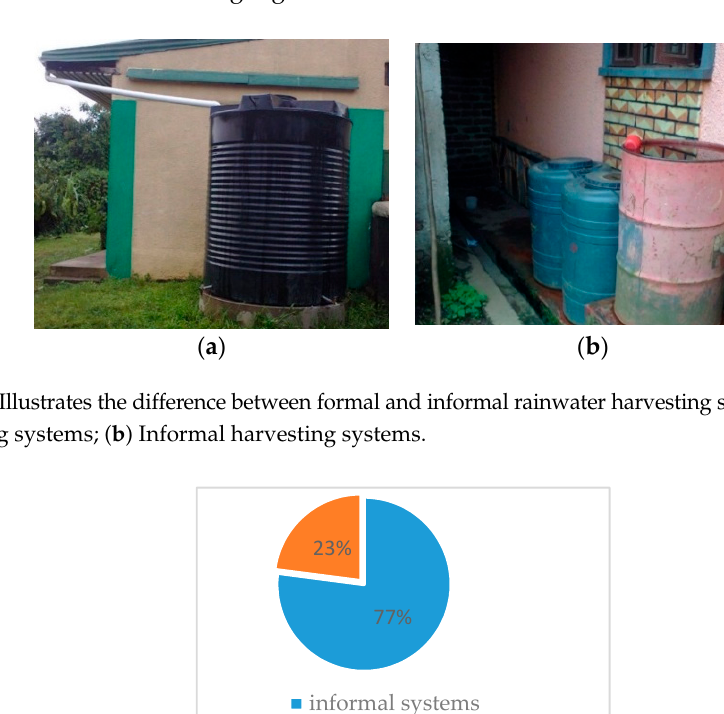
Figure 6. Climate change prediction of daily average rainfall for 2025–2055. As shown in Figure 7, for 2060–2090 projections, greater deviations from observed rainfall are predicted by MIROC5, HADGEM2-CC and HADGEM2-ES models. For instance, during the MAM